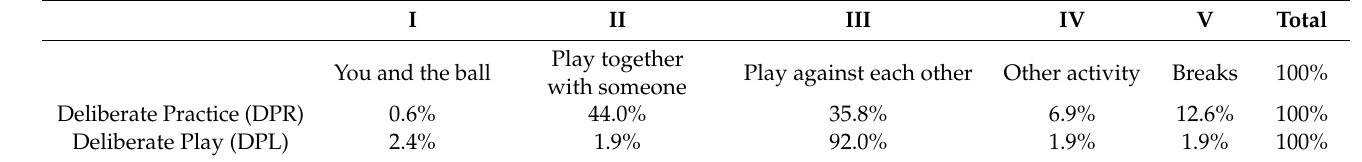
Table 2. Percentages of the time spent in different kinds of activities between deliberate practice and deliberate play, registered on the average rates per every 5 min played.